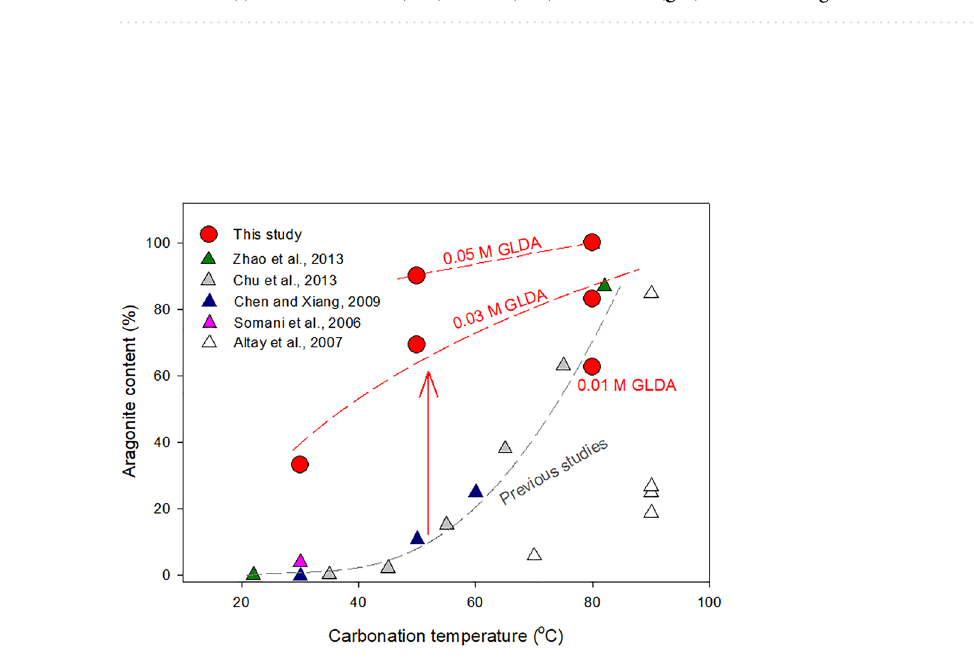
Figure 10. SEM images of CaCO 3 particles produced in the presence of ( a , d , g ) 0 M, ( b , e , h ) 0.01 M, ( c , f ) 0.03 M, and ( i ) 0.1 M GLDA at ( a – c ) 30 °C, ( d – f ) 50 °C, and ( g – i ) 80 °C. A: aragonite, C: calcite, V: vaterite.